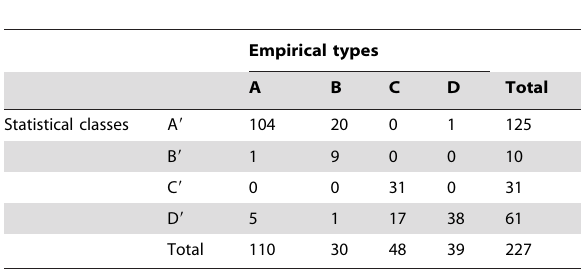
Table 3. Confusion matrix for classification by the statistical models versus the empirical